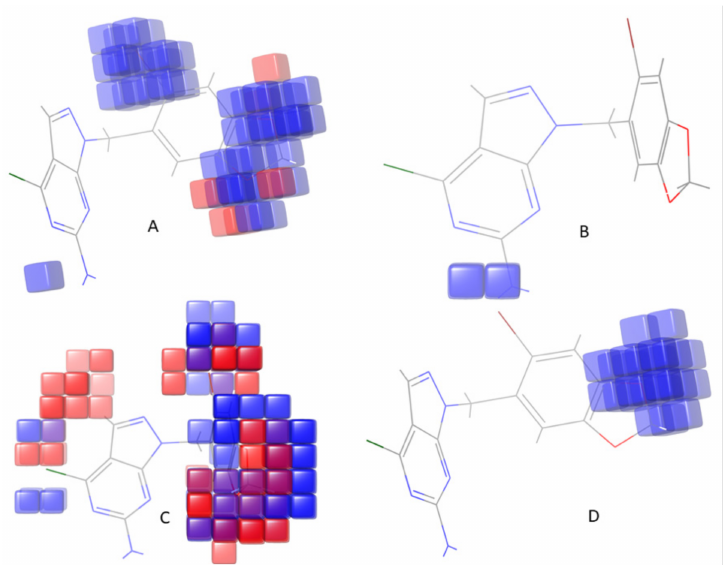
Figure 5. Atom-based 3D-QSAR model visual representation: ( A ) electron-withdrawing, ( B ) hydro- gen bond donor, ( C ) hydrophobic, ( D ) positive ionic, where blue-colored cubes represent positive coefficients or an increase in activity, and red-colored cubes represent negative coefficients or decrease in the